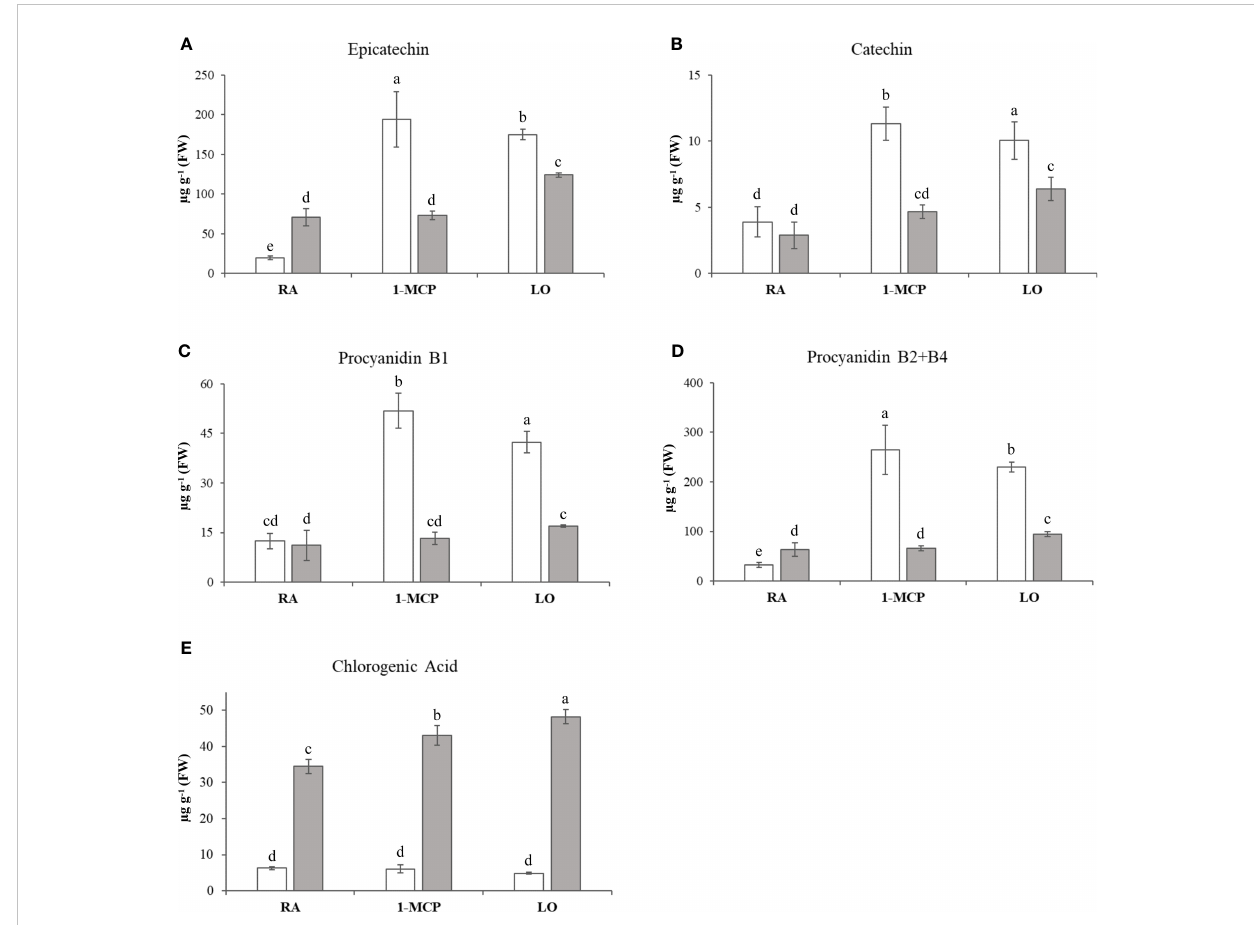
FIGURE 2 Flavan-3-ols quanti fi cation in ‘ Granny Smith ’ (withe bar) and ‘ Ladina ’ (grey bar). (A) epicatechin, (B) catechin, (C) procyanidin B1, (D) procyanidin B2 +B4 and chlorogenic acid (E) . The concentration is expressed as µg·g -1 of fresh weight (FW). The error bars correspond to the standard deviation. RA, Regular Atmosphere; 1-MCP, Regular Atmosphere + 1-MCP treatment; LO, Low Oxygen condition. Fisher ’ s least signi fi cant difference (LSD) test was applied, p-value ≤ 0.01. Different letters indicate difference statistically signi fi